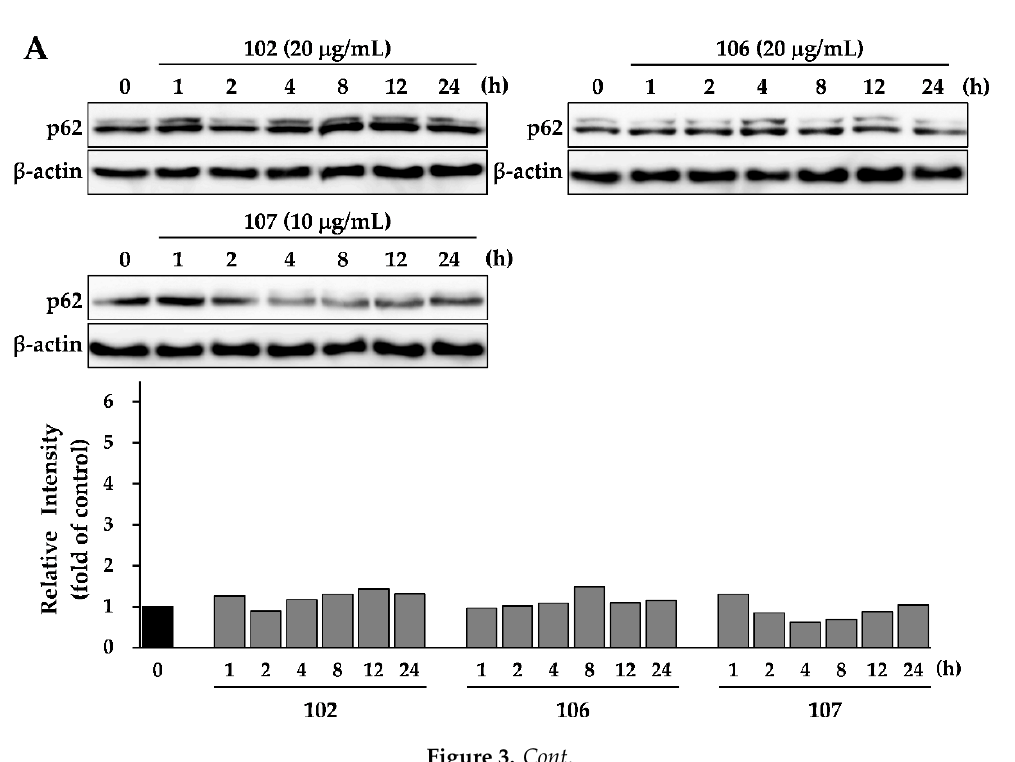
Figure 3. Effects of eight crude extracts on p62 expression in HepG2 cells. Cells were treated with each crude extract at the indicated concentrations and for different durations. The expressions levels of p62 and β-actin were determined by Western blotting. ( A ) The effect of crude extracts on cell viability. ( B )